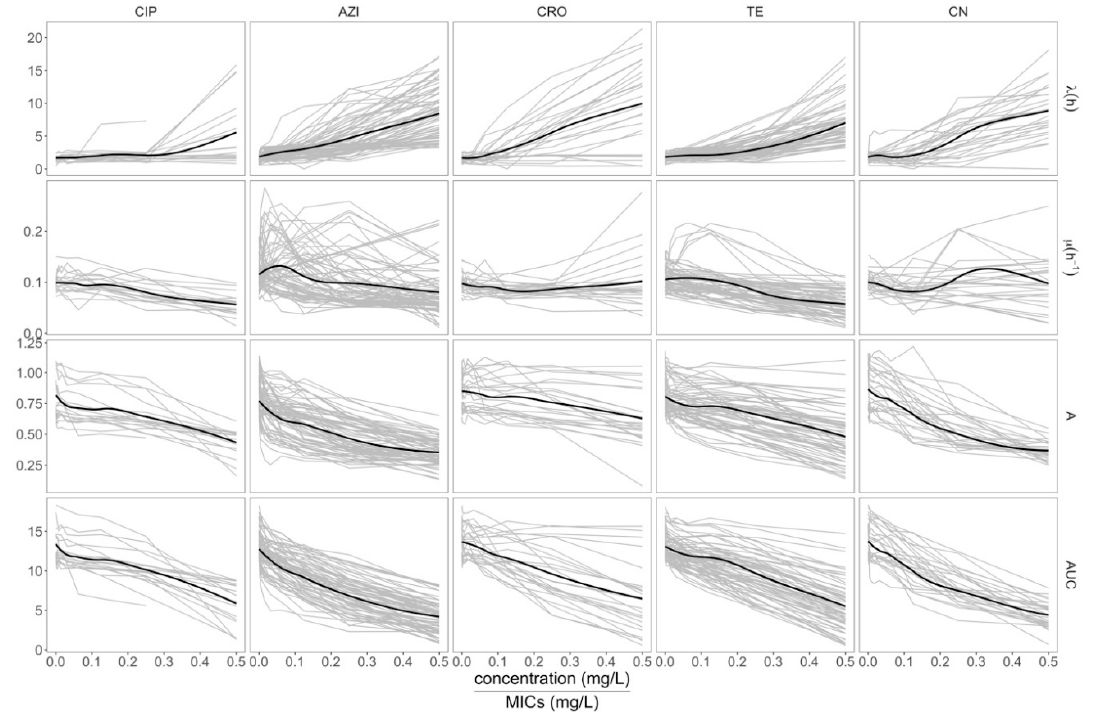
Figure 2. The dynamics of the growth features. From top to bottom, lag-phase period ( λ ), maximum growth rate ( µ ), maximum cell density (A), and area under the curve (AUC) corresponding to antimicrobial concentration relative to MICs of 28 E. coli isolates from clinical samples. From left to right, ciprofloxacin (CIP), azithromycin (AZI), ceftriaxone (CRO), tetracycline (TE), and gentamicin (CN). The horizontal axis is antimicrobial concentrations relative to MICs of each isolate. The vertical axis represents the values of growth features. Bold lines are loess smooth functions and thin lines are the growth features of each isolate.